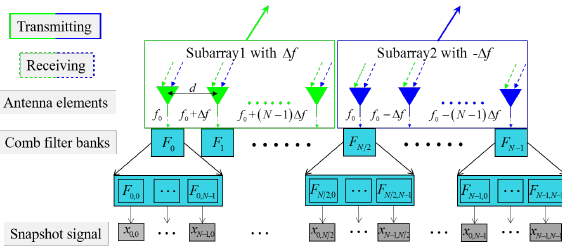
Figure 1. Illustration of transmit and receive antenna array